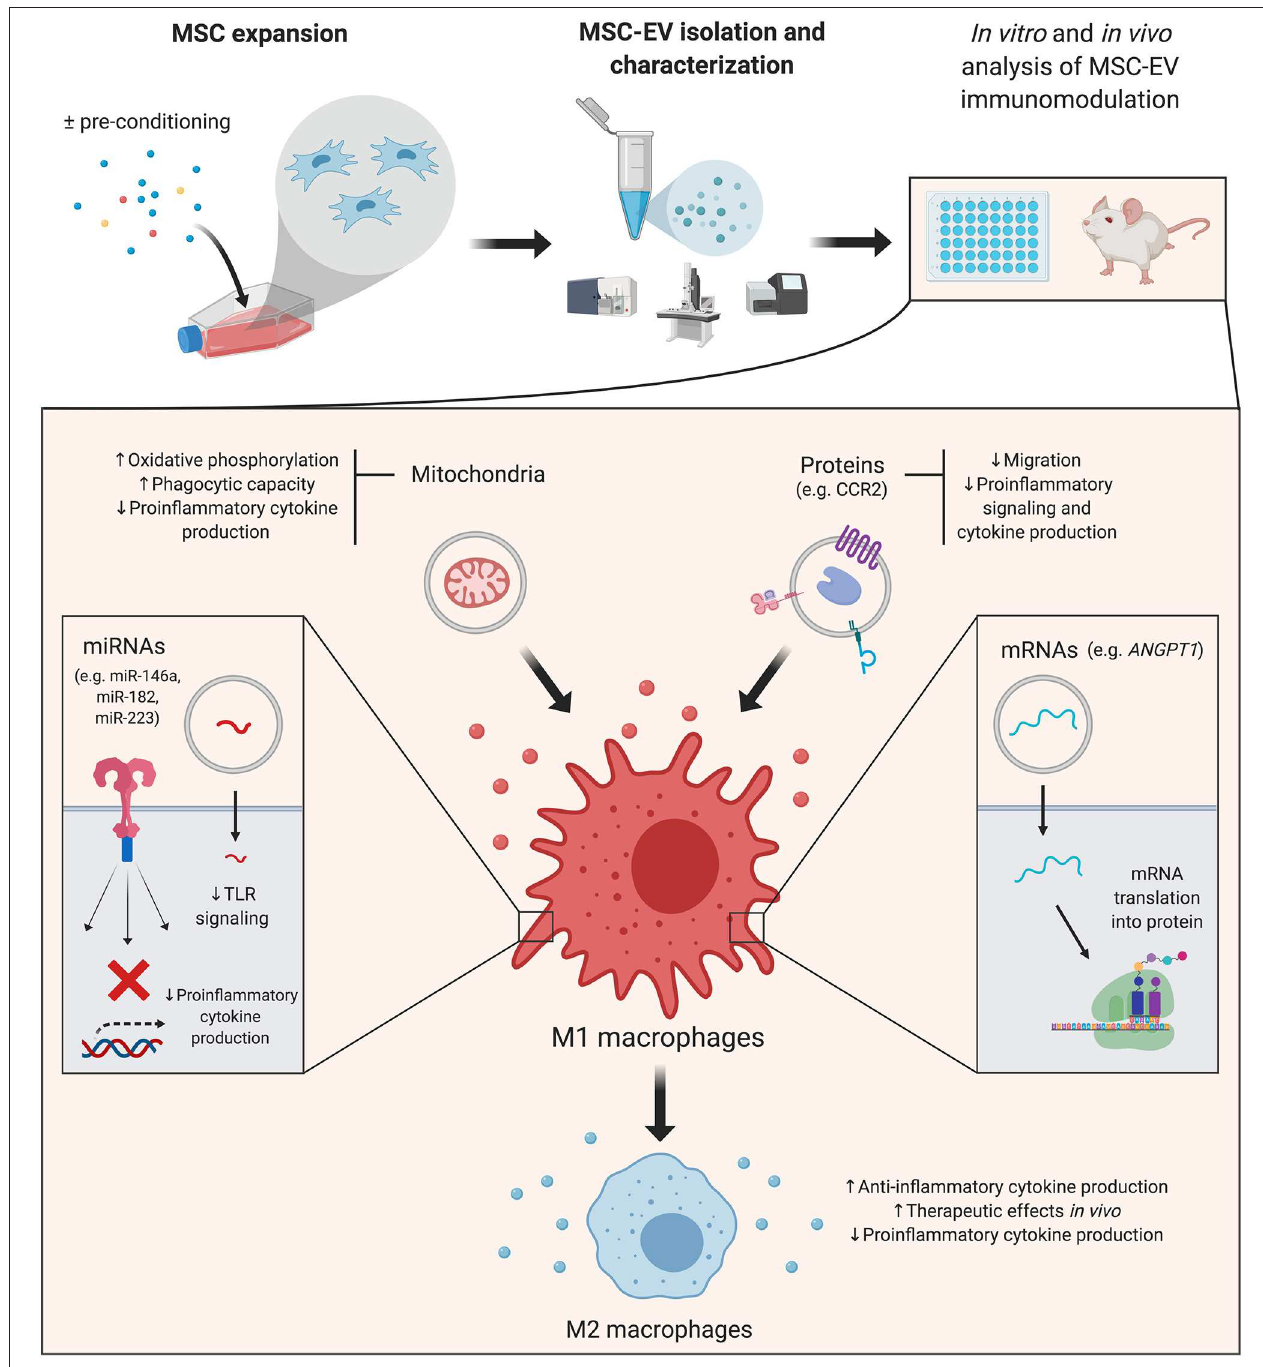
FIGURE 1 | Mesenchymal stromal cell-derived extracellular vesicles (MSC-EVs): cargo’s effects on macrophages. A simplified overview of the main effects triggered by MSC-EV cargo in macrophages–which are the focus of the majority of reviewed studies–is presented. MSC-EVs are isolated from cultured cells, which can be pre-conditioned with different strategies to increase their immunomodulatory potential. Details of the effector molecules, signaling pathways and mediated immunological effects are presented in the main text. ANGPT1 , angiopoietin 1; CCR2, membrane receptor chemokine (C-C motif) receptor 2; miRNA, microRNA; MSC, mesenchymal stromal cell; MSC-EV, mesenchymal stromal cell-derived extracellular vesicle; TLR, toll like receptor. Created with BioRender.com. dendritic cells’ CCR7 levels, a chemokine receptor with a antigen uptake in immature dendritic cells, limited their crucial role in mature dendritic cell lymph node homing maturation and activation and increased anti-inflammatory (Comerford et al., 2013). In this study, MSC-EVs also reduced cytokine